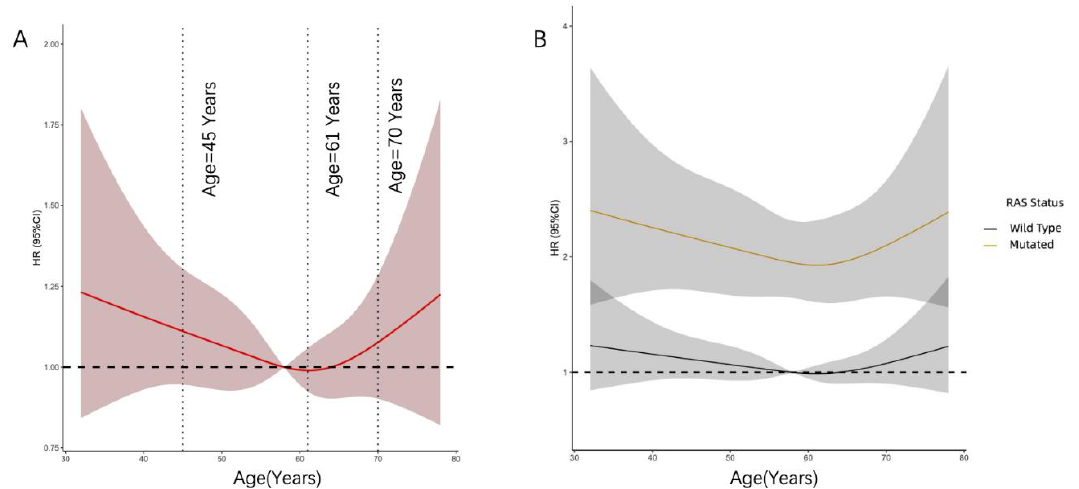
Figure 1. ( A ) The relationship between OS and age in the whole cohort was explored with the RCS function based on the Cox ’ s equation. ( B ) The effect of the age on the prognosis of CRLM between different RAS status.